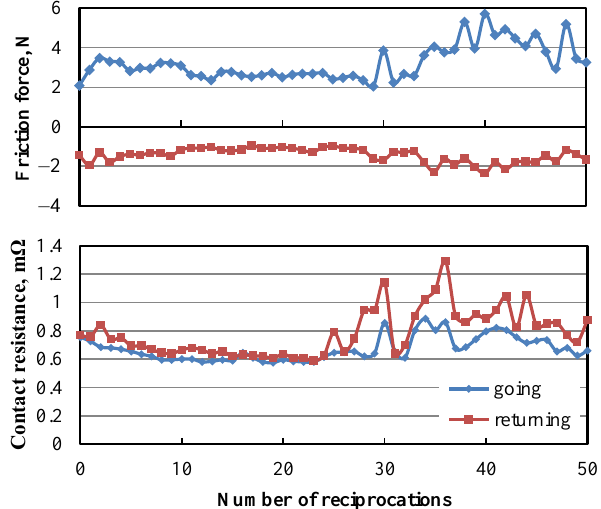
Figure 3. Changes in the frictional force and the electrical contact resistance ( t = 0.2 mm, Ag plating 1 µm, v = 100 mm/min).